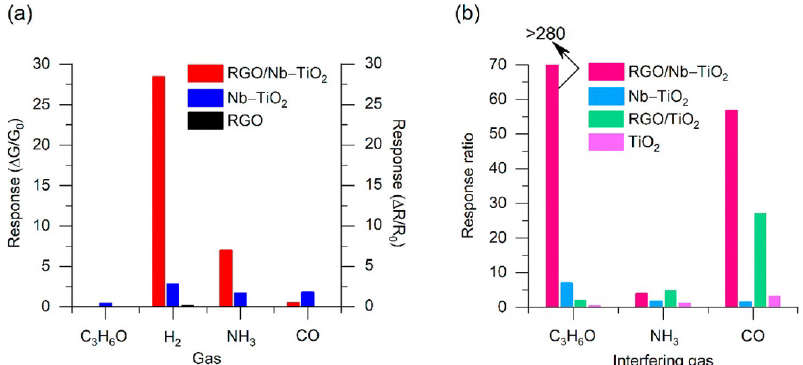
Figure 31. ( a ) Response of RGO/Nb –TiO 2 (prepared using 9 ng/mm 2 GO, optimal composition), Nb–TiO 2 NTs, and RGO (prepared with 9 ng/mm2 GO) toward C 3 H 6 O (120 ppm), H 2 (120 ppm), CO (120 ppm), and NH 3 (30 ppm) at their optimal working temperature (200 ◦ C). ( b ) Response ratio calculated as the response toward H 2 (120 ppm) with respect to C 3 H 6 O (120 ppm), CO (120 ppm), and NH 3 (30 ppm) for RGO/Nb–TiO 2 (prepared using 9 ng/mm 2 GO), Nb–TiO 2 , RGO/TiO 2 (prepared with 4.5 ng/mm 2 GO, the optimal composition of RGO/TiO 2 ), and pristine TiO 2 samples at an operating temperature of 200 °C. The RGO/Nb –TiO 2 hybrid material (prepared with 9 ng/mm 2 GO) is not sensitive toward C 3 H 6 O at the optimal operating temperature, so we can only provide a lower bound for the response ratio: >280 means that the response of RGO/Nb –TiO 2 (prepared using 9 ng/mm 2 GO) toward C 3 H 6 O is 0.1 when calculating the H 2 /C 3 H 6 O response ratio. Reprinted from [122]. {001} facet has excellent acetone-sensing performances compared to TiO 2 nanorods with an exposed {110} facet because of the high-energy {001} [185,186 ] crystal facets of TiO 2 and TiO 2/ SiC heterojunctions [183]. Murali et al. found a 4.8-fold enhancement in the response